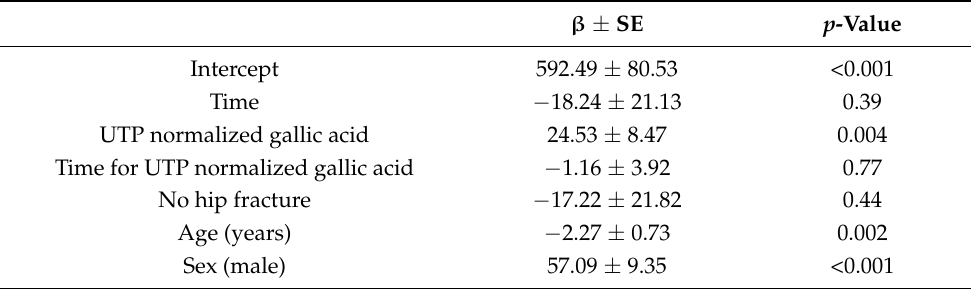
Table 5. Linear mixed model. Factors associated with total dietary polyphenols (TDPs) assumption, variation through the times of the study assessed with European Prospective Study into Cancer and Nutrition s(EPIC) questionnaire. Urinary total polyphenol (UTP) concentrations were expressed as normalized mg of gallic acid equivalents (GAE) per 24-hour urine. Linear Mixed Model estimates are reported as β ±